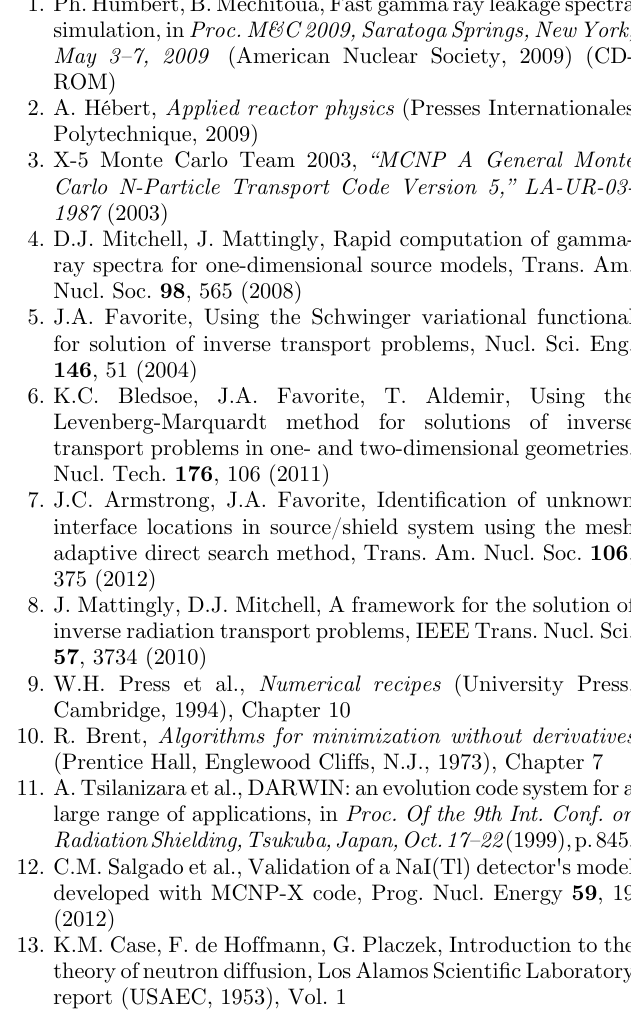
Table 4. Results of the optimization, external radius.